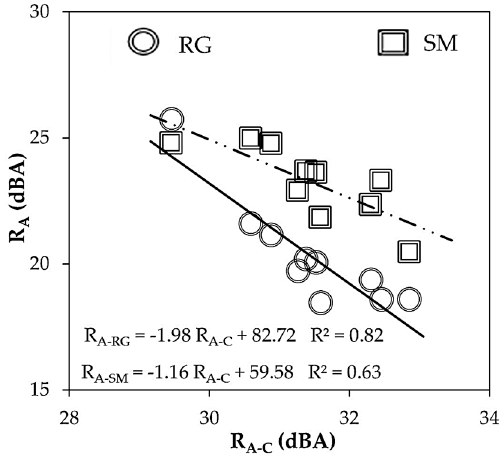
Figure 4. Experimental sound reduction index (R A ) on rough (RG) and smooth (SM) sides versus estimated sound reduc- tion index (R A-C ), according to the acoustic mass